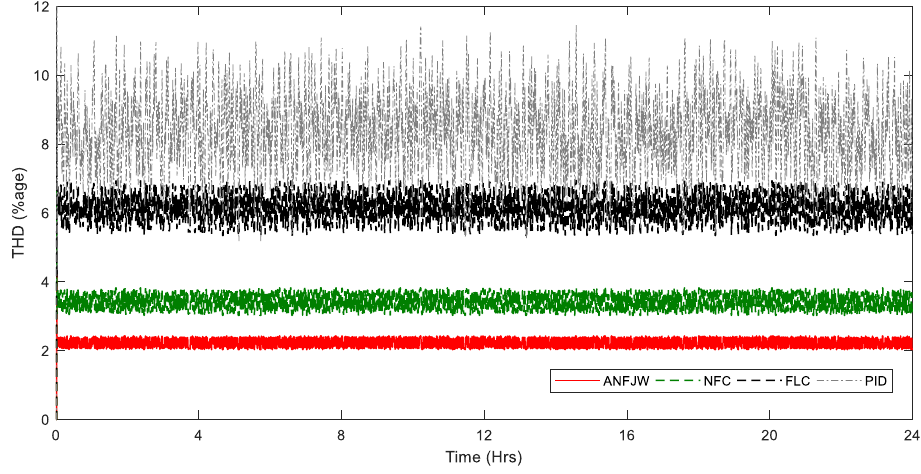
Figure 15. Total harmonic distortion (THD) comparison.